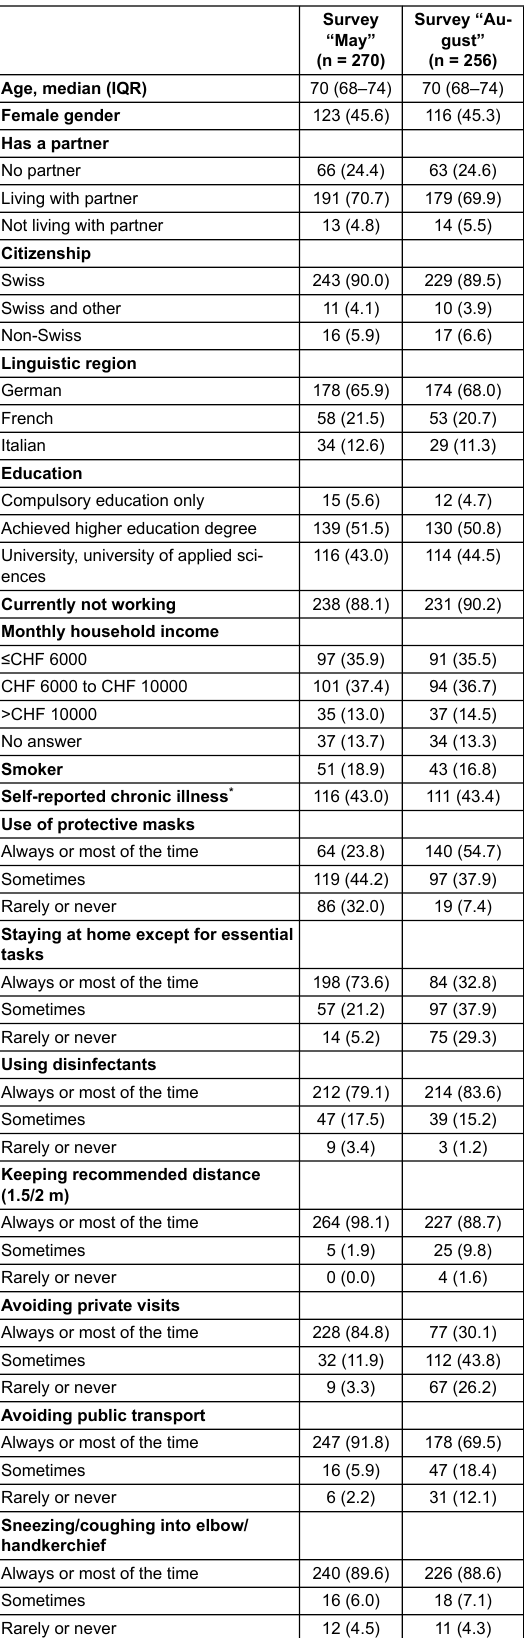
Table 1: Demographic characteristics and adherence to recommend- ed preventive measures in the Swiss COVID-19 Social Monitor as- sessed at survey “May” and survey “August” of persons aged 65 years or